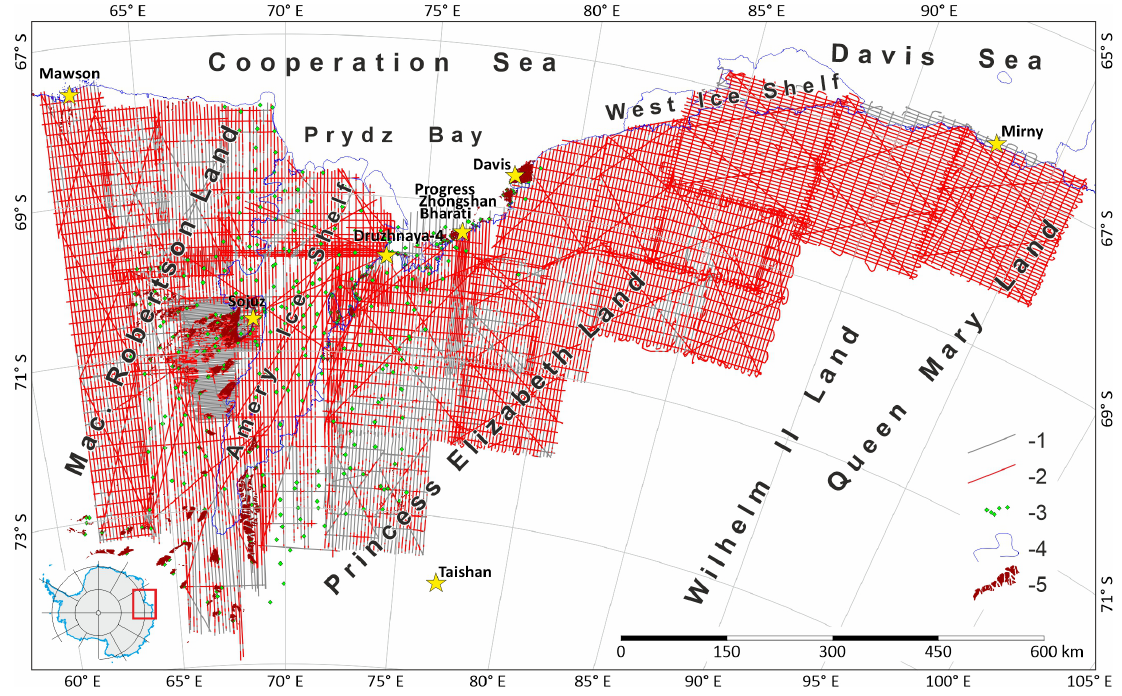
Figure 1. Locations of airborne RES and seismic reflection soundings. 1—Airborne RES flights; 2—portions of RES flights with reflection from the ice base; 3—seismic reflection soundings; 4—ice front and grounding line from [20]; 5—outcrops from